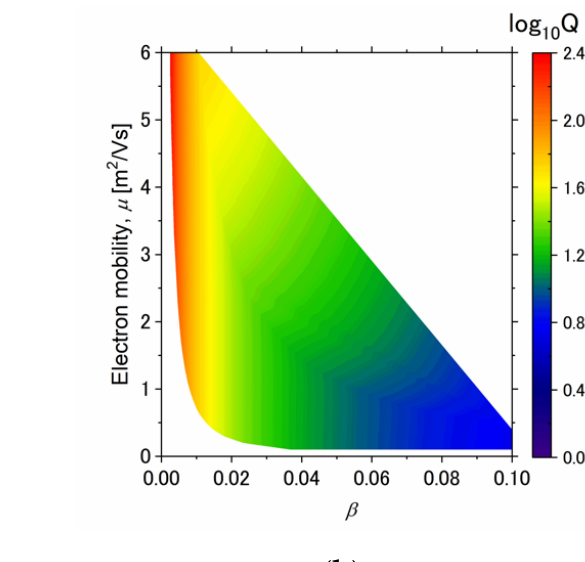
Table 2. Design parameters and obtained quality factors of graphene ribbon metasurface used for the calculation in Figure 7a.